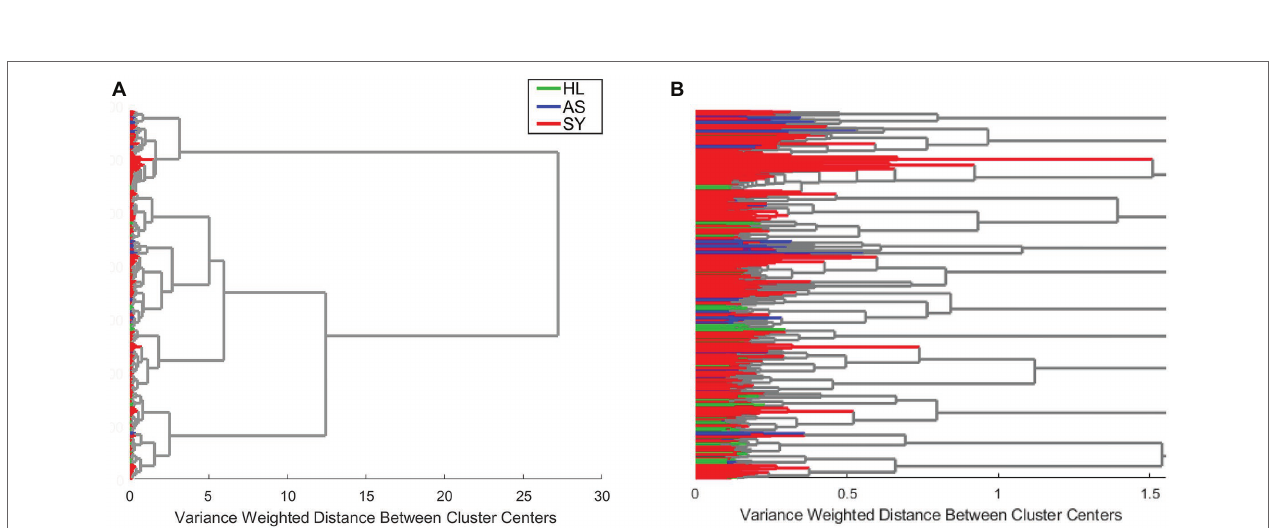
FIGURE 4 | Example clustering dendrogram at full size (A) or zoomed in to reveal the details of individual clusters (B) . HL—healthy control; AS—asymptomatic;